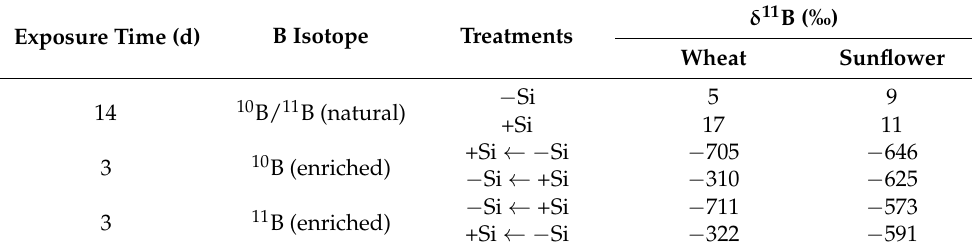
Table 5. Effect of pulsed Si supply on δ 11 B changes in the cell wall material isolated from the youngest fully expanded leaves of wheat and sunflower at excess